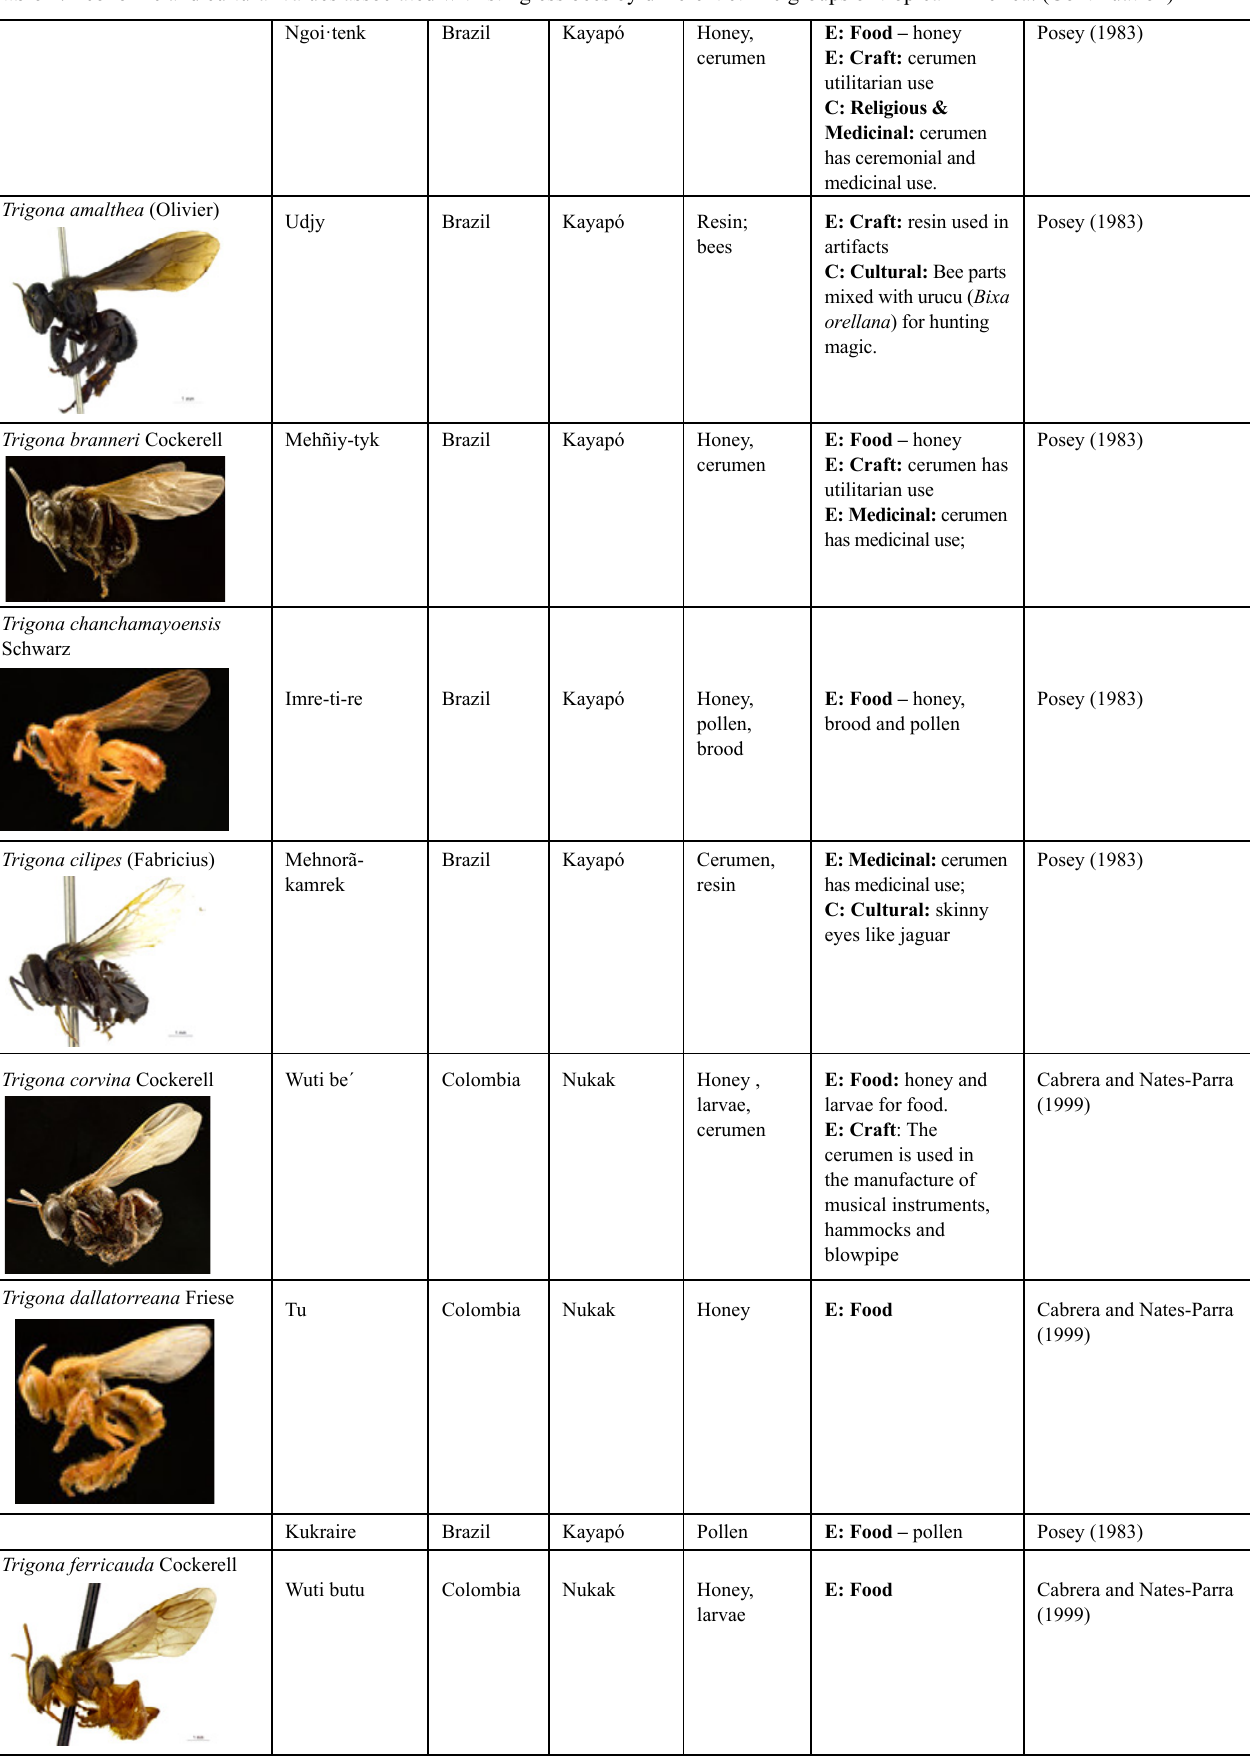
Table 1 . Economic and cultural values associated with stingless bees by different ethnic groups of tropical America.